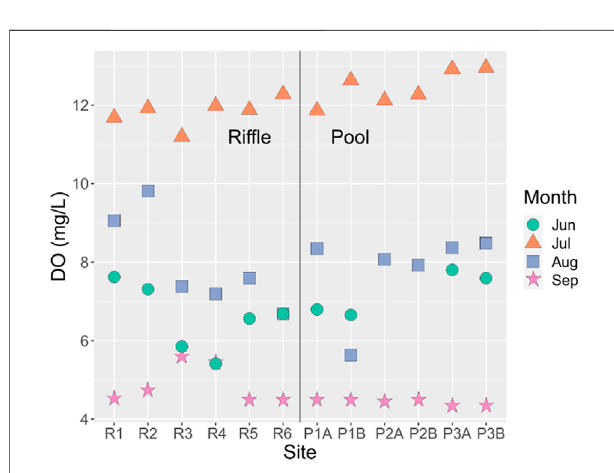
FIGURE 7 | Dissolved oxygen (DO) concentrations recorded in June, July, August, and September at each macroinvertebrate sampling site in the Otter Park study reach. Sites are ordered from downstream (left) to upstream